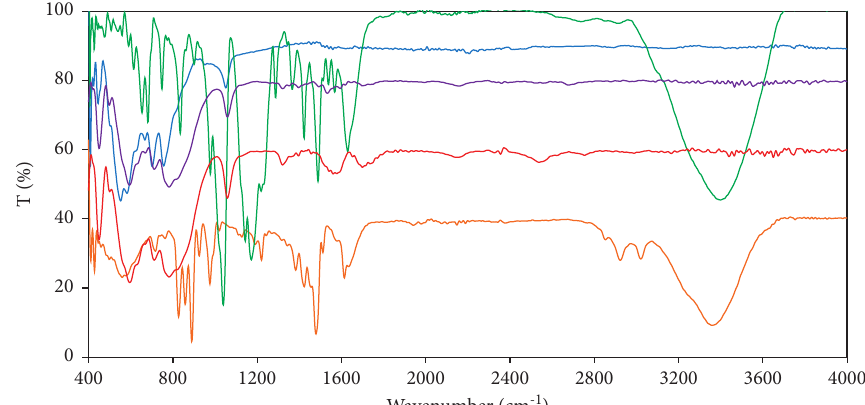
Figure 5: FT-IR spectra of: ( ) α -Al2O3 particles, ( ) polycation PVBTAC, ( ) azo dye NCC, ( ) PVBTAC-modified α -Al2O3 particles and ( ) NCC-adsorbed-PVBTAC-modified α -Al2O3 particles.